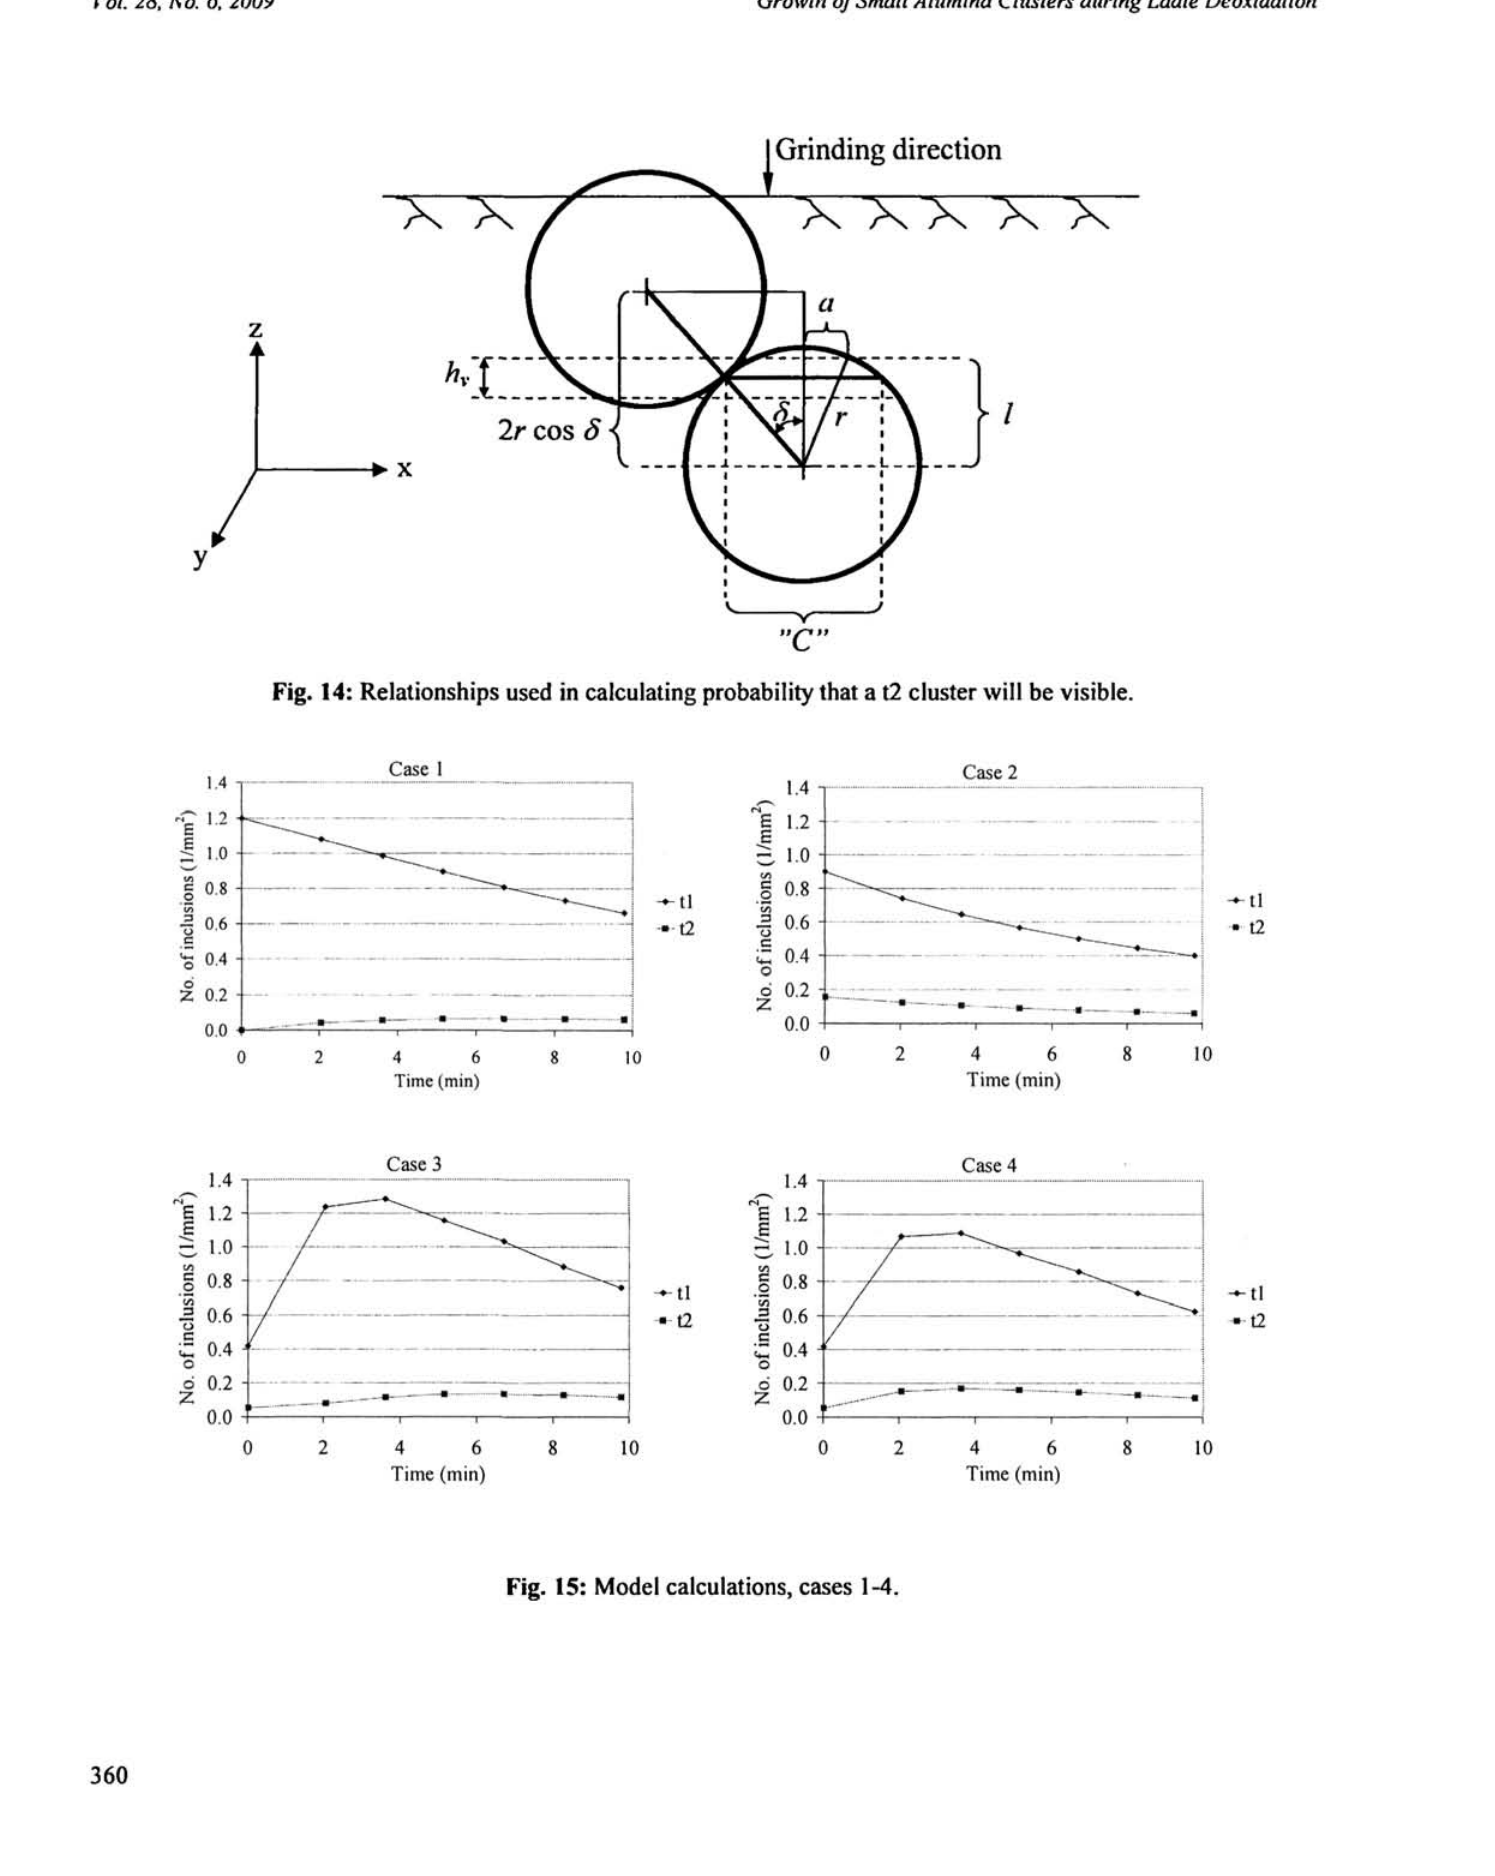
Fig. 15: Model calculations, cases